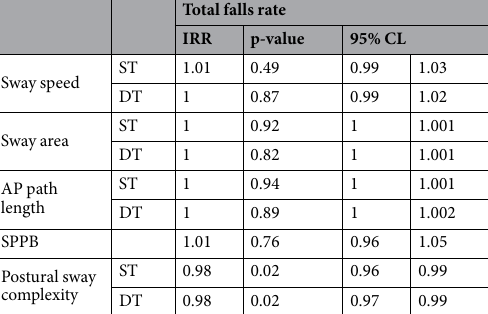
from each time-series (C). As compared to the non-faller, the sample entropy of the current faller was lower across multiple scales of time. As such, postural sway complexity (i.e., the area under the MSE curve) of the par- ticipant who experienced falls was considerably less than the participant who did not. In contrast, other metrics of postural sway, including sway speed, sway area and AP path length, were quite similar between these two study participants. The associations between baseline postural sway metrics (i.e., complexity, sway speed, sway area, and AP path length) and the rate of future falls were analyzed using negative binomial regression analyses. Results indicated that the complexity of postural sway during ST (incident rate ratio (IRR) = 0.98, p = 0.02, 5% Confidence Limits (CL): 0.96–0.99) and DT (IRR = 0.98, p = 0.02, 95% CL: 0.97–0.99) was negatively associated with future falls rate (Table 2); one unit difference of either single or dual task postural sway complexity associated with 2% difference in future falls rate. In other words, participants with lower baseline postural sway complexity had a higher rate of future falls. These relationships were independent of age, sex, BMI and historical falls. Conversely, SPPB score or traditional postural sway measures (i.e., sway speed, area, and AP path length) did not significantly predicted the incidence of future falls (IRRs = 1~1.01, p > 0.49).